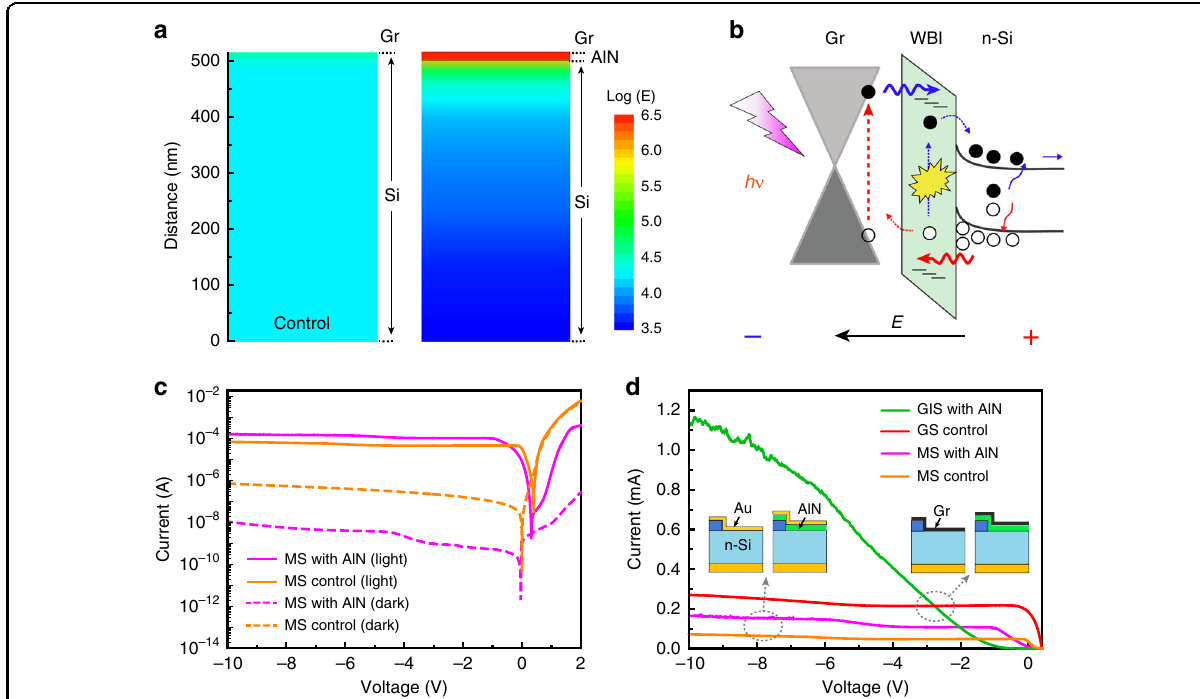
Fig. 4 Proposed tunneling mechanism of the GIS devices with comparison to the conventional metal-semiconductor (MS) structure. a Simulated electric- fi eld distribution near the junction for the devices of GS and GIS for a comparison (AlN is 15.3 nm and the bias is − 10 V). b Proposed working mechanisms of the GIS heterojunction photodetector showing the tunneling process from minority carriers of silicon and hot carriers from graphene with impact ionization. c The I-V curves of MS tunneling photodetector with 15.3-nm AlN comparing with the conventional MS Schottky photodetector under dark and light illumination (365 nm and 12.2 mW cm − 2 ). d Comparison of the photocurrent for the MS and GIS/GS devices with and without AlN tunneling layer under the reverse bias. The incident light was 365 nm and in a power of 12.2 mW cm − 2